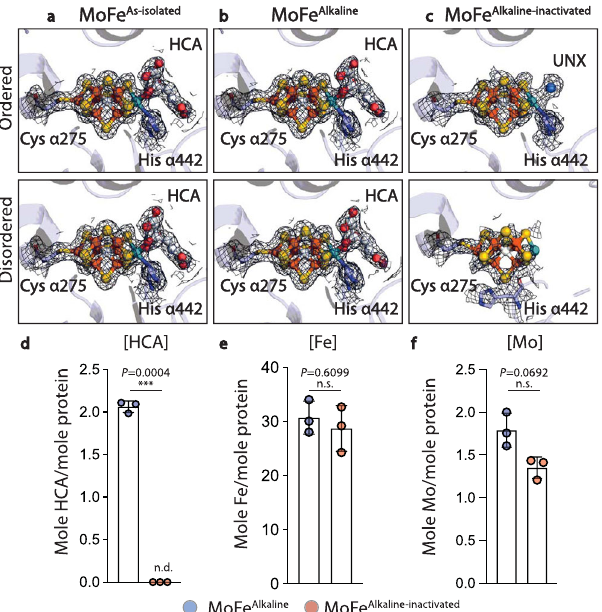
Fig. 2 | Structure and composition of the alkaline turnover-inactivated MoFe- protein active site. a CryoEM density carved around the FeMo-cofactor at 7 σ in MoFe As-isolated puri fi ed from A. vinelandii demonstrating the presence of the FeMo- cofactor coordinated by Cys α 275, His α 442, and an HCA in both αβ dimers. b CryoEM density carved around the FeMo-cofactor at 7 σ in MoFe Alkaline isolated from a control acetylene reduction reaction mixture at pH 9.5 without ATP, demonstrating the maintenance of the FeMo-cofactor coordinated by Cys α 275, His α 442, and an HCA in both αβ dimers. c CryoEM density carved around the FeMo-cofactor at 7 σ in MoFe Alkaline-inactivated isolated from an acetylene reduction assay at pH 9.5 with ATP, demonstrating the presence of the FeMo-cofactor coordinated by Cys α 275, His α 442, andanunknown ligand (UNX)in the HCAsite in the ordered αβ dimer (top panel). The loss of recognizable density for the FeMo-cofactor and the HCA is evident in the disordered αβ dimer (lower panel). d Quanti fi cation of homocitrate by an IC-MS method developed for this work illustrates the approximately expected 2 moles HCA per mole of tetrameric protein in MoFe Alkaline (blue circles), however, HCA was not detected (n.d.) within the MoFe Alkaline-inactivated samples (red circles), which have been represented as zero values in this data. e ICP-MS metal quanti fi cation of Fe illustrates a decrease from the mean of 30.7 moles Fe permole protein in MoFe Alkaline to a mean of 28.7 moles FepermoletetramericproteininMoFe Alkaline-inactivated . f ICP-MSmetalquanti fi cation of Mo shows a decrease from the mean of 1.79 moles Mo per mole protein in MoFe Alkaline to a mean of 1.35 moles Mo per mole tetrameric protein in MoFe Alkaline-inactivated . Each data point in panels d – f represents a protein isolated from an independent reaction and columns are shown as the mean±sd. Statis- tical analyses of three distinct replicates shown in panels d – f used paired t -tests and two-tailed P values greater than 0.05 were considered not signi fi cant (n.s.). Source data are provided as a Source Data fi le. HCA R -Homocitrate, Fe iron, Mo